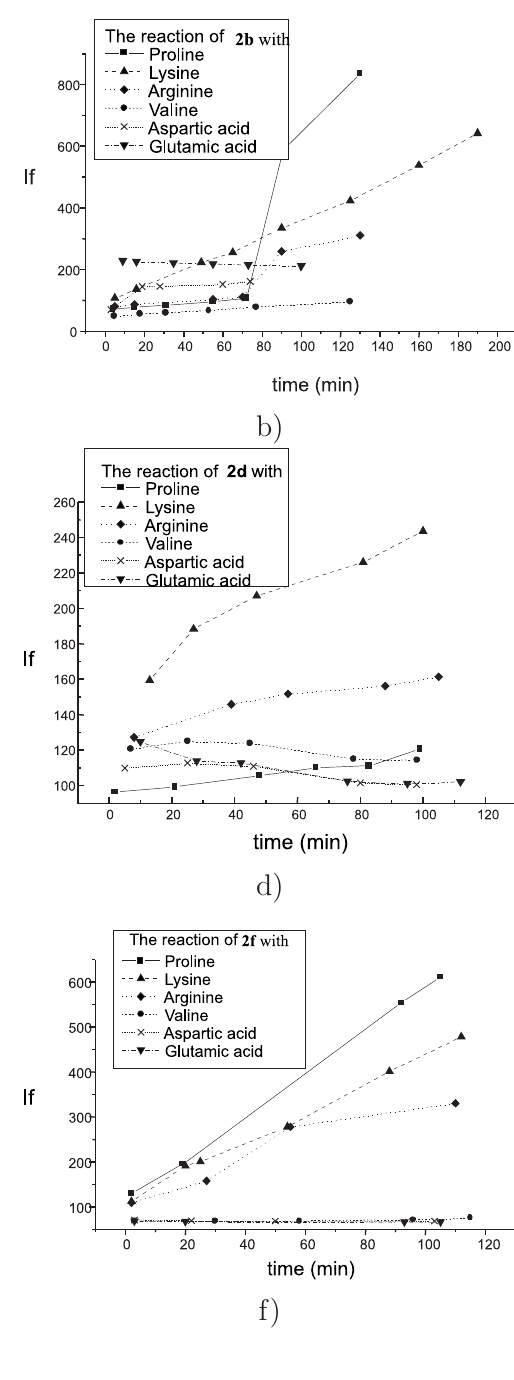
Fig. 1 Variation in time of the intensity of fluorescence (If) during the reaction (in 99.6 % ethanol at 25 ◦ C) of amino acids with compounds 2a – 2f ( λ ex = 480 nm, λ em = 540 nm); concentration 2a-f = 2 × 10 − 3 mol/L; concentration of amino acid = 4 × 10 − 3